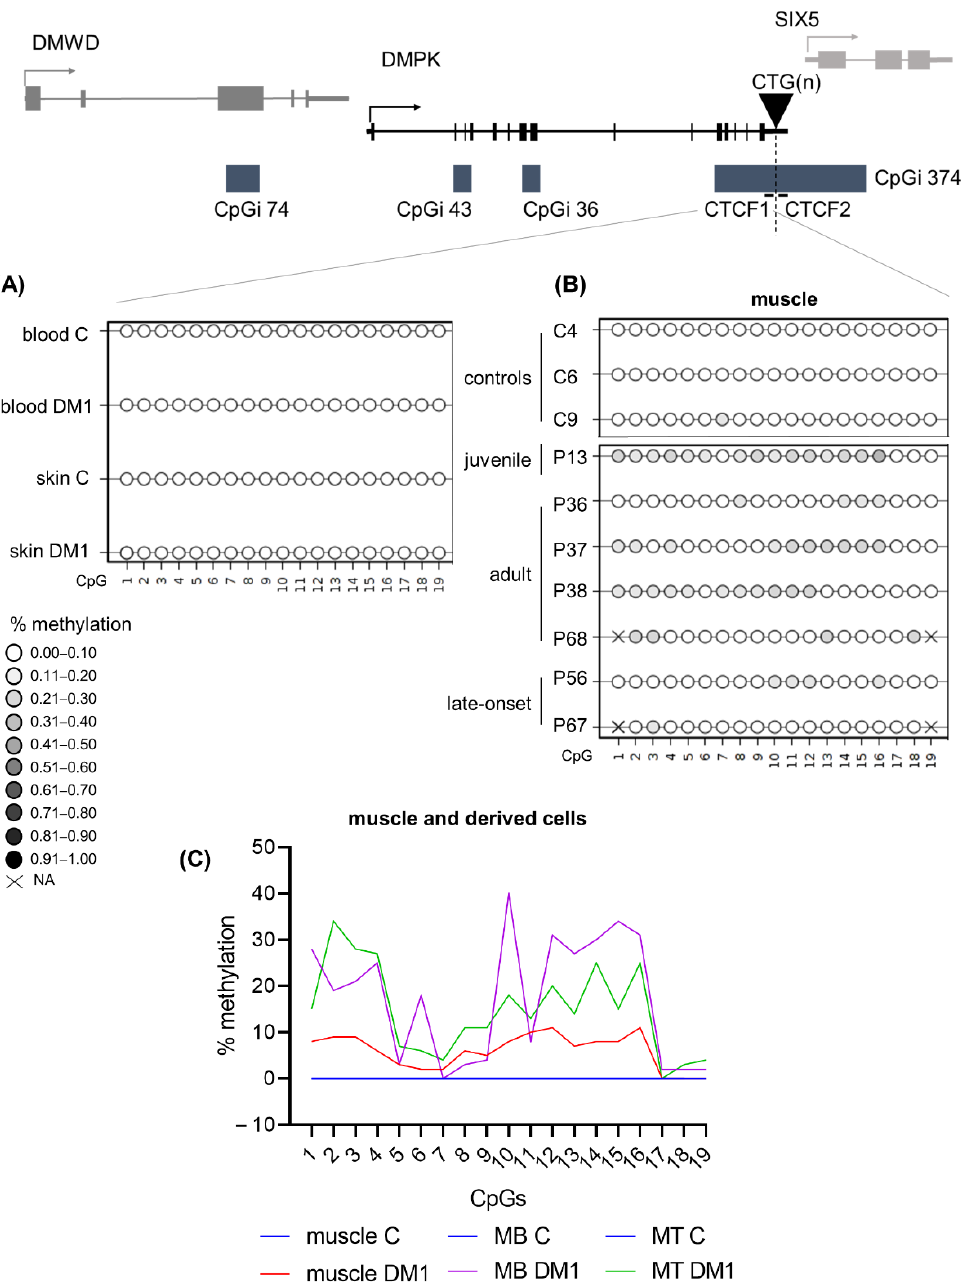
Figure 5. DNA methylation profiles at the CTCF1 regions were tissue-specific and increased in DM1 muscle samples. ( A ) Averages of DNA methylation profiles across blood and skin in patients versus controls for CTCF1. Included patients are from the juvenile, adult and late onset clinical category ( n = 5 for blood, n = 3 for skin and n = 4 for controls). ( B ) Overview of the muscle biopsy DNA methylation profiles of DM1 patients and controls. Each circle represents a CpG dinucleotide. The color gradient represents the level of methylation indicated in the legend assessed by sodium bisulfite sequencing. ( C ) Representation of the DNA methylation profiles of muscle and muscle-derived cells (myoblasts and myotubes) in CTCF1. For CTCF1 all control muscle cells are at zero and have been given the same color to aid visualization.